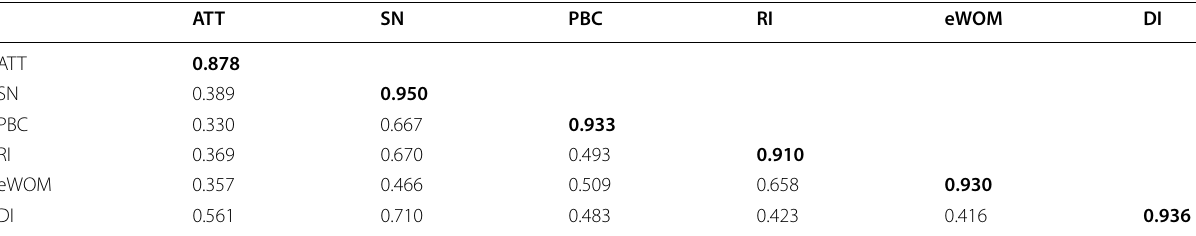
Table 5 Discriminant validity. Source : Primary